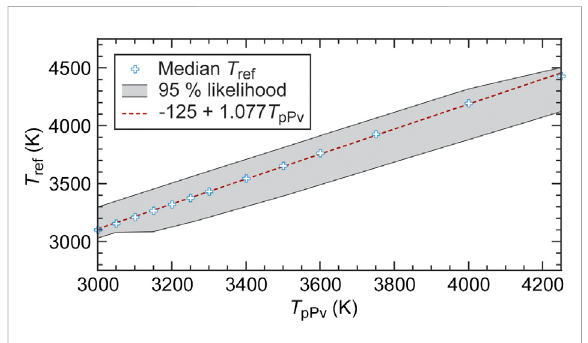
Reference temperature in the lowermost 50 km of the mantle, T ref , estimated from attenuation and shear velocity measured beneath Central America (Borgeaud and Deschamps, 2021) and the Northern Paci fi c (Deschamps et al., 2019) as a function of the transition temperature to post-perovskite, T pPv . The crosses show T ref median values, meaning that there is 50% likelihood that T ref is on each side of this value. The dashed red curveshows thelinear fi ttothesemedianvalues,andthegrayarea covers values of T ref ranging from quartiles 0.025 to 0.975, i.e. , the likelihood that T ref is within this range is 95%. The CMB